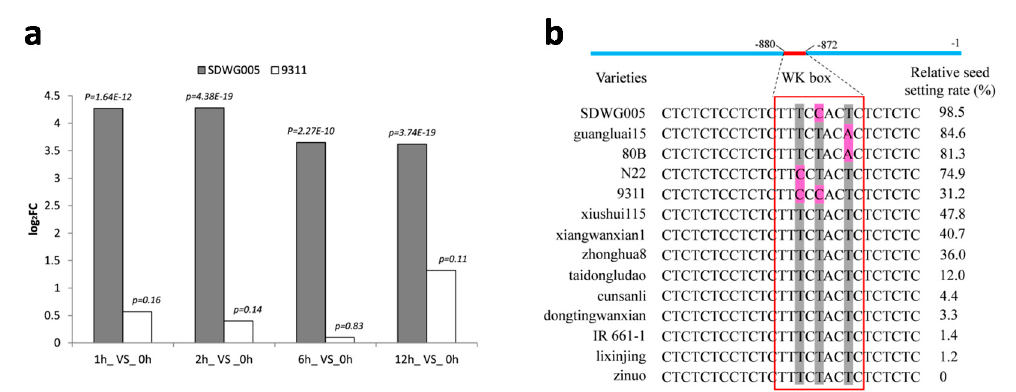
Figure 8. Expression and polymorphic analysis of OsACT . ( a ) Expression levels of OsACT in anthers of SDWG005 and 9311 under heat treatments by qRT-PCR. ( b ) Polymorphic analysis of WK-box in SDWG005, 9311, N22, and rice core collections with different thermotolerance. Pink indicates minor allele, gray indicates major allele; Relative seed setting rate data was from Zha et al. [20].